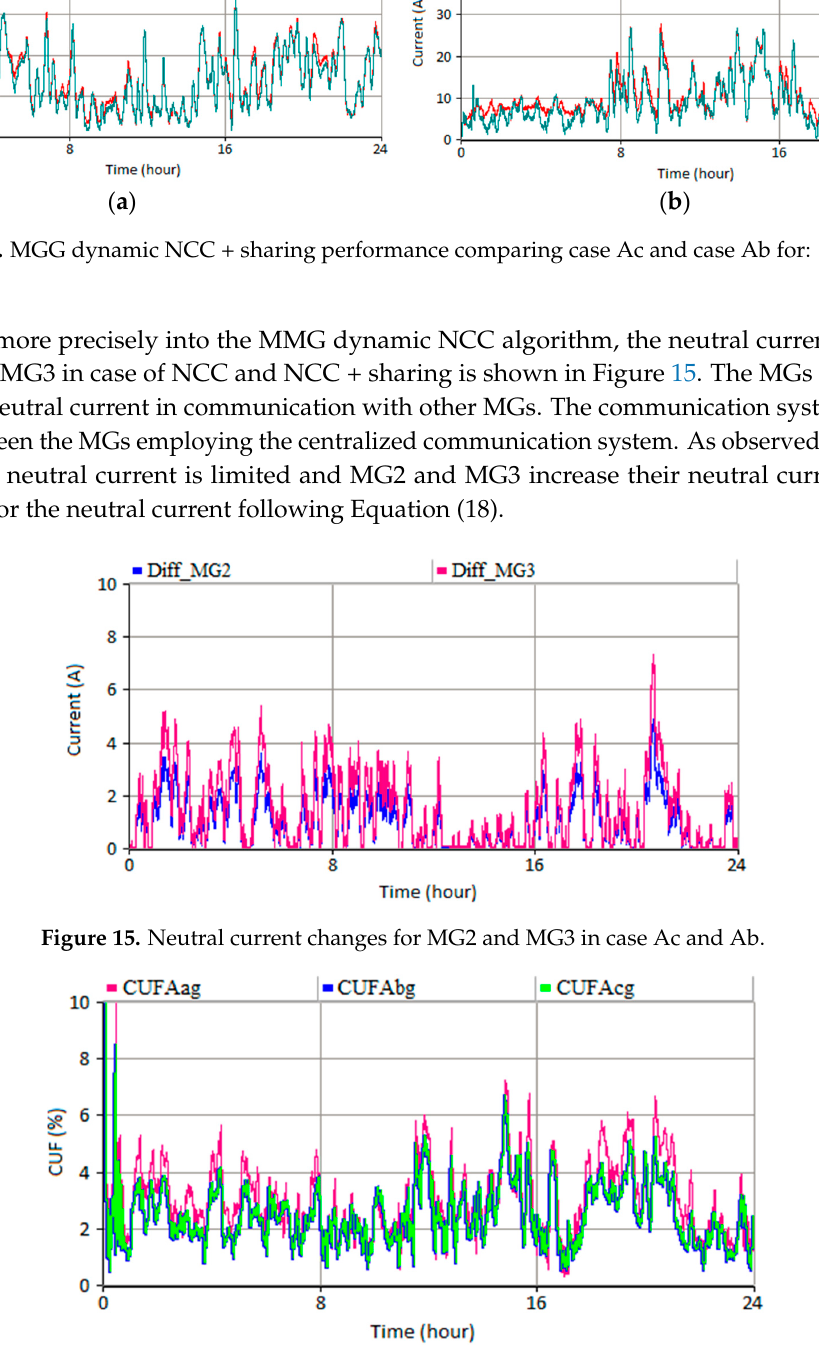
Figure 16. Current Unbalance Factor (CUF) comparison at PCC for case Aa, Ab and Ac.